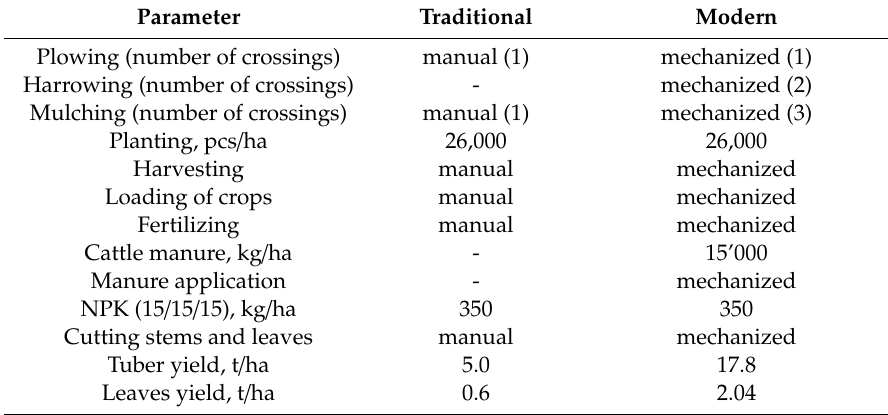
Table 1. Main characteristics of traditional and modern cassava production system under